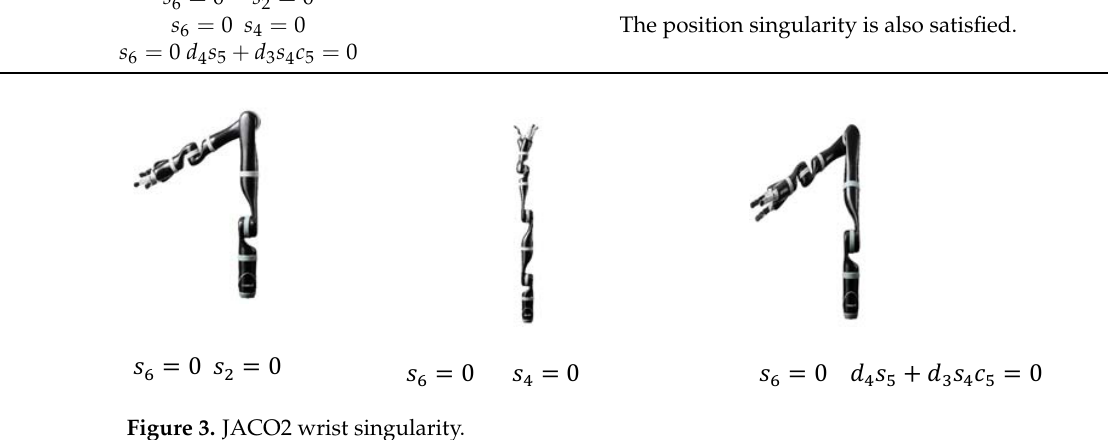
Figure 3. JACO2 wrist singularity.